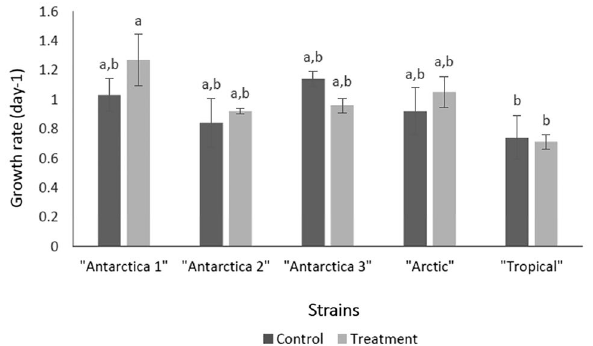
Figure 2. Mean (± standard error) of the growth rate of each of five strains of Stichococcus -like algae in control (BBM) versus BBM + 1000 µg/mL CHX. Means sharing the same letter (a, b) are not significantly different (Tukey’s HSD).